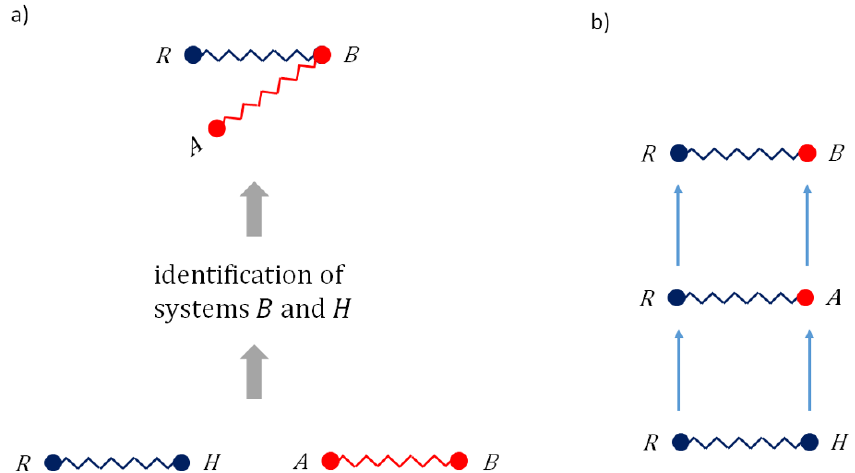
Figure 8 . In the AMPS experiment we can label the system inside the black hole which is correlated with a reference system by H . When this information leaves the black hole as Hawking radiation, we identify it with the outgoing Hawking radiation B . Thus in AMPS, the polygamous entanglement comes from identi(cid:12)cation of system H and B , while keeping systems A and R uncorrelated. In the temporal product picture, H and B are identi(cid:12)ed by H being the past of A which is the past of B .